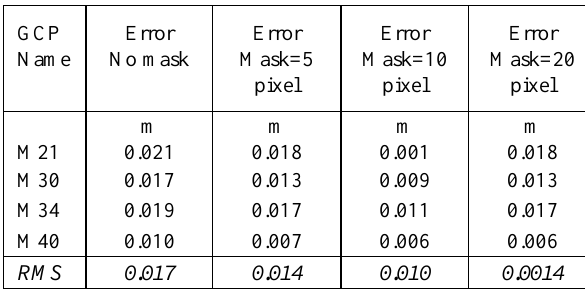
Table 7. Residuals of the markers obtained with action